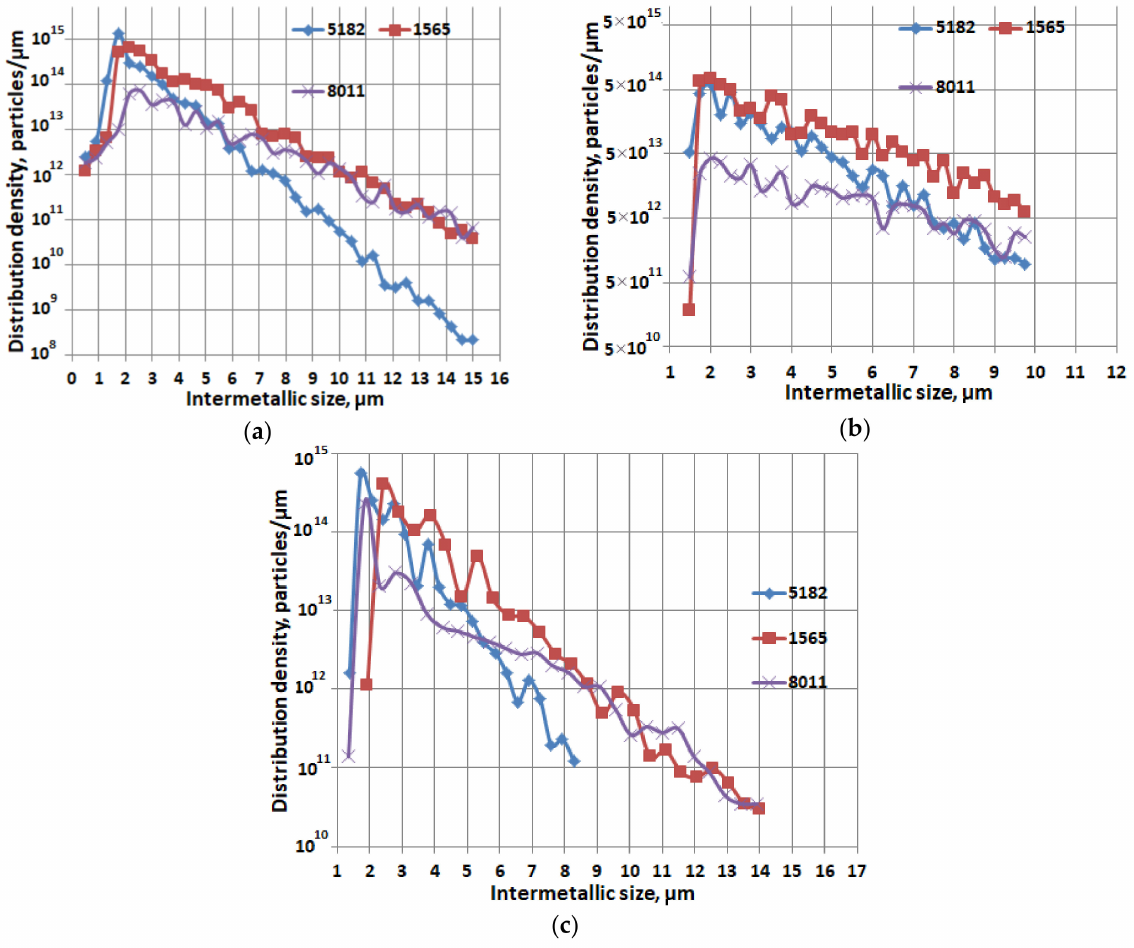
Figure 14. Distribution density of the sizes of intermetallic compounds in homogenized ( a ), after deformation ~0.4 logarith- mic strain ( b ) and ~1.8 ( c ) logarithmic